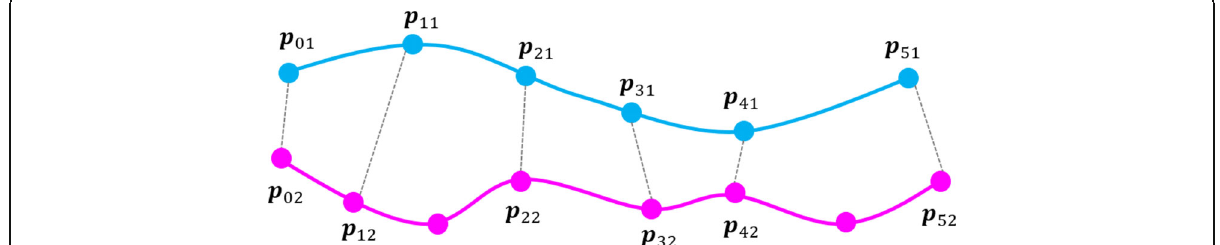
Fig. 2 Coupling vertices to calculate the difference between a pair of streamlines. Pink curve line and cyan one are a pair of streamlines. Black dot is a seed point of this pair of streamlines, and gray dots are vertices of